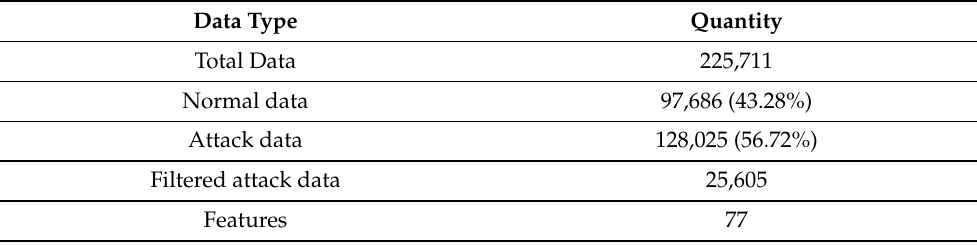
Table 1. Dataset